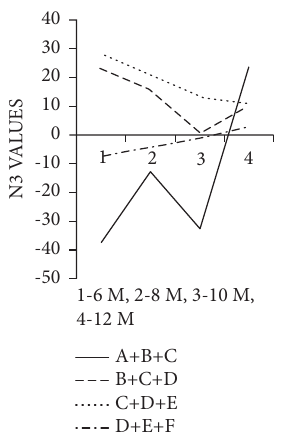
Figure 12: N3 values with increasing molarity alkaline solution (28 days’ curing) combinations.